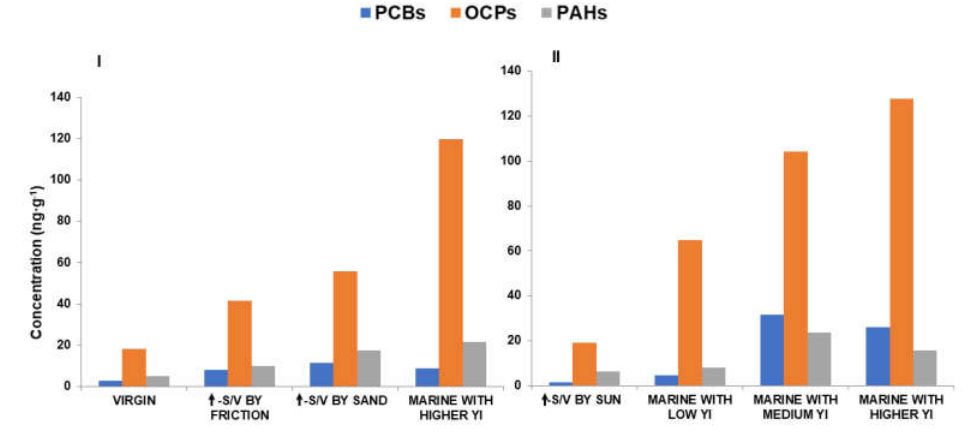
Figure 6. Total concentration of POPs (PCBs, OCPs and PAHs) adsorbed onto PE pellets obtained according to the degradation state of the MP sample. ( I ) Physical degradation and ( II ) chemical degradation.